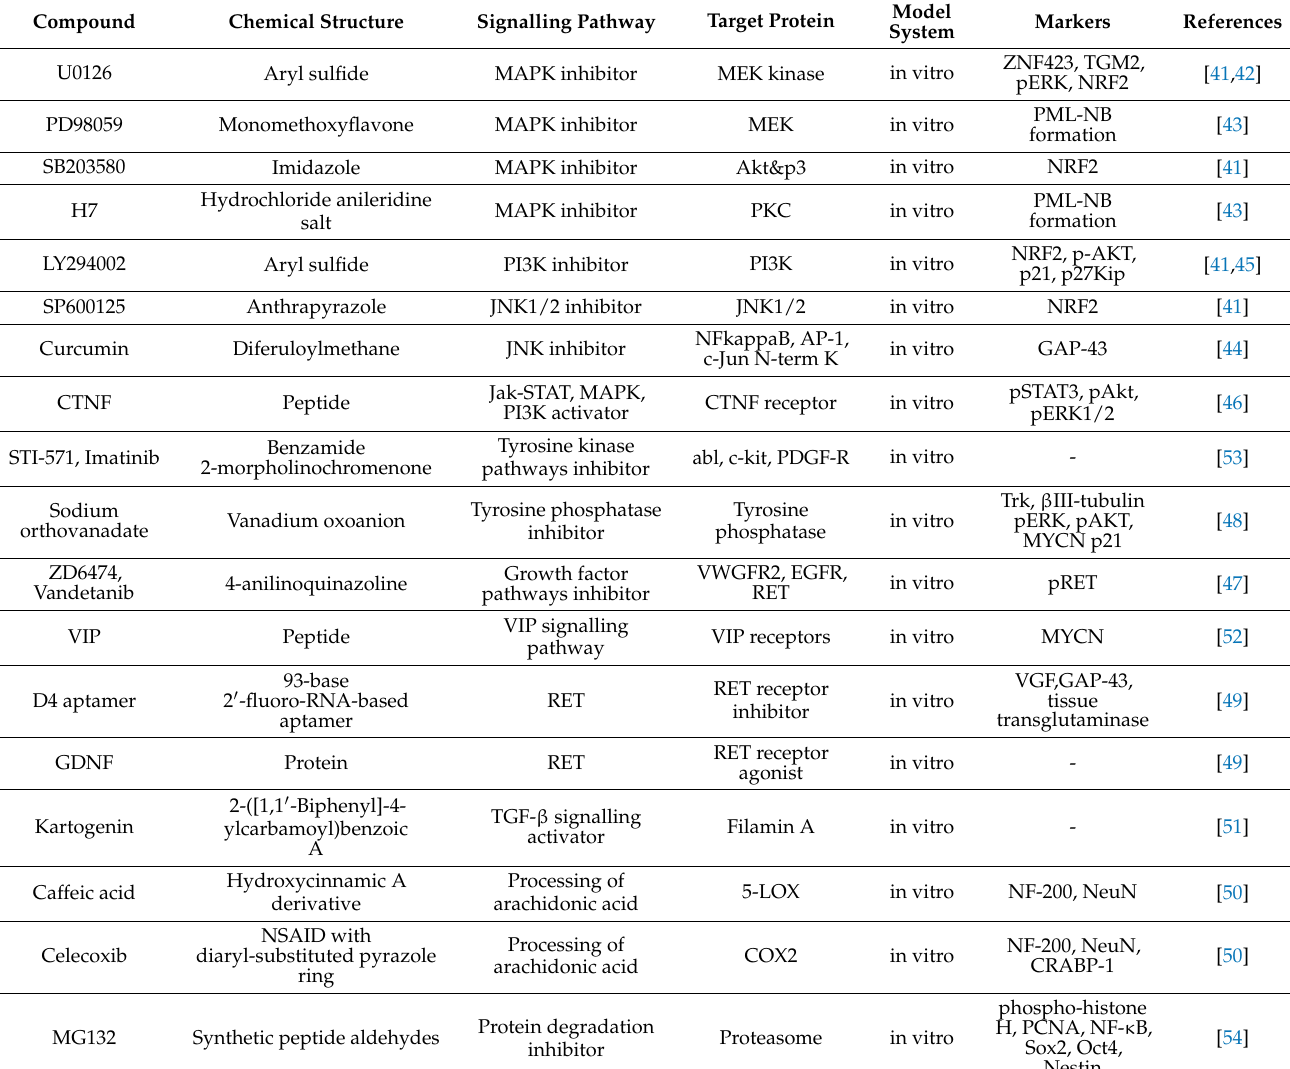
Table 2. Summary of the drugs that activate cellular